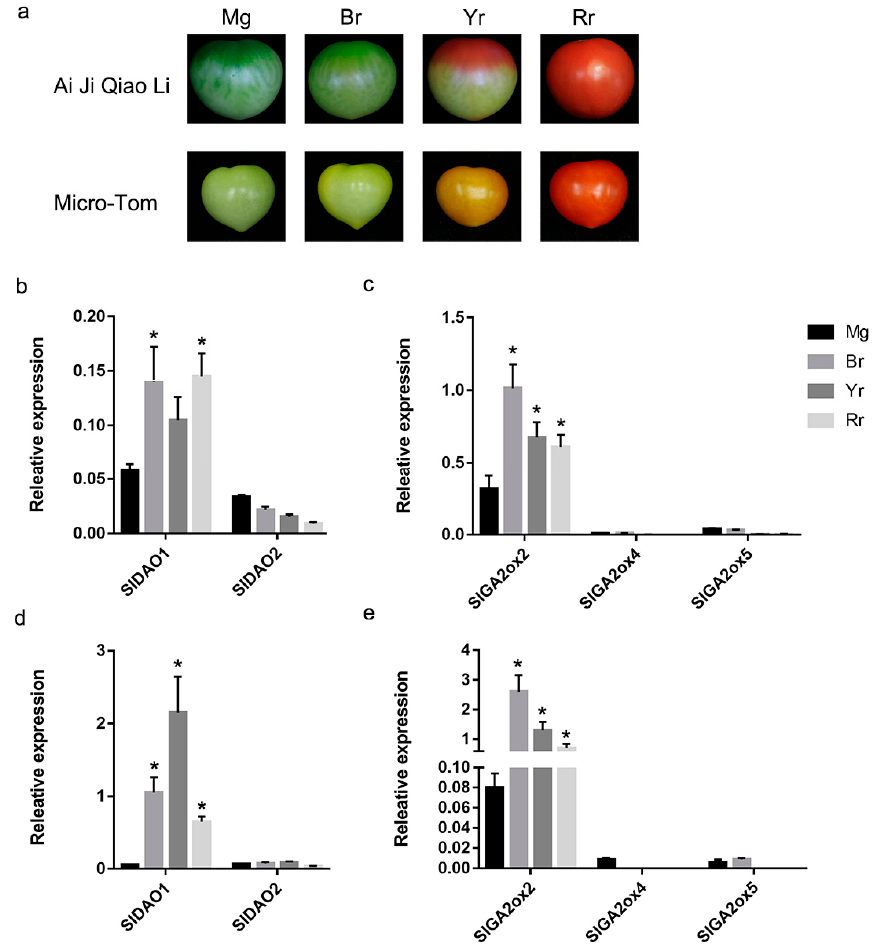
Figure 5. Expression analysis of SlDAOs and SlGA2oxs genes during tomato fruit ripening in the pericarp. ( a ) Different ripening stages of Ai Ji Qiao Li and Micro-Tom. ( b ) Expression levels of SlDAOs in Ai Ji Qiao Li. ( c ) Expression levels of SlGA2ox genes in Ai Ji Qi Li. ( d ) Expression levels of SlDAOs in Micro-Tom. ( e ) Expression levels of SlGA2ox genes in Micro-Tom. Mg: mature-green; Br: breaker; Yr: yellow-ripening; Rr: red-ripening. * The asterisk at the top of each column indicates a significant difference compared to Mg fruits at p < 0.05 ( n = 3) by students t-test.